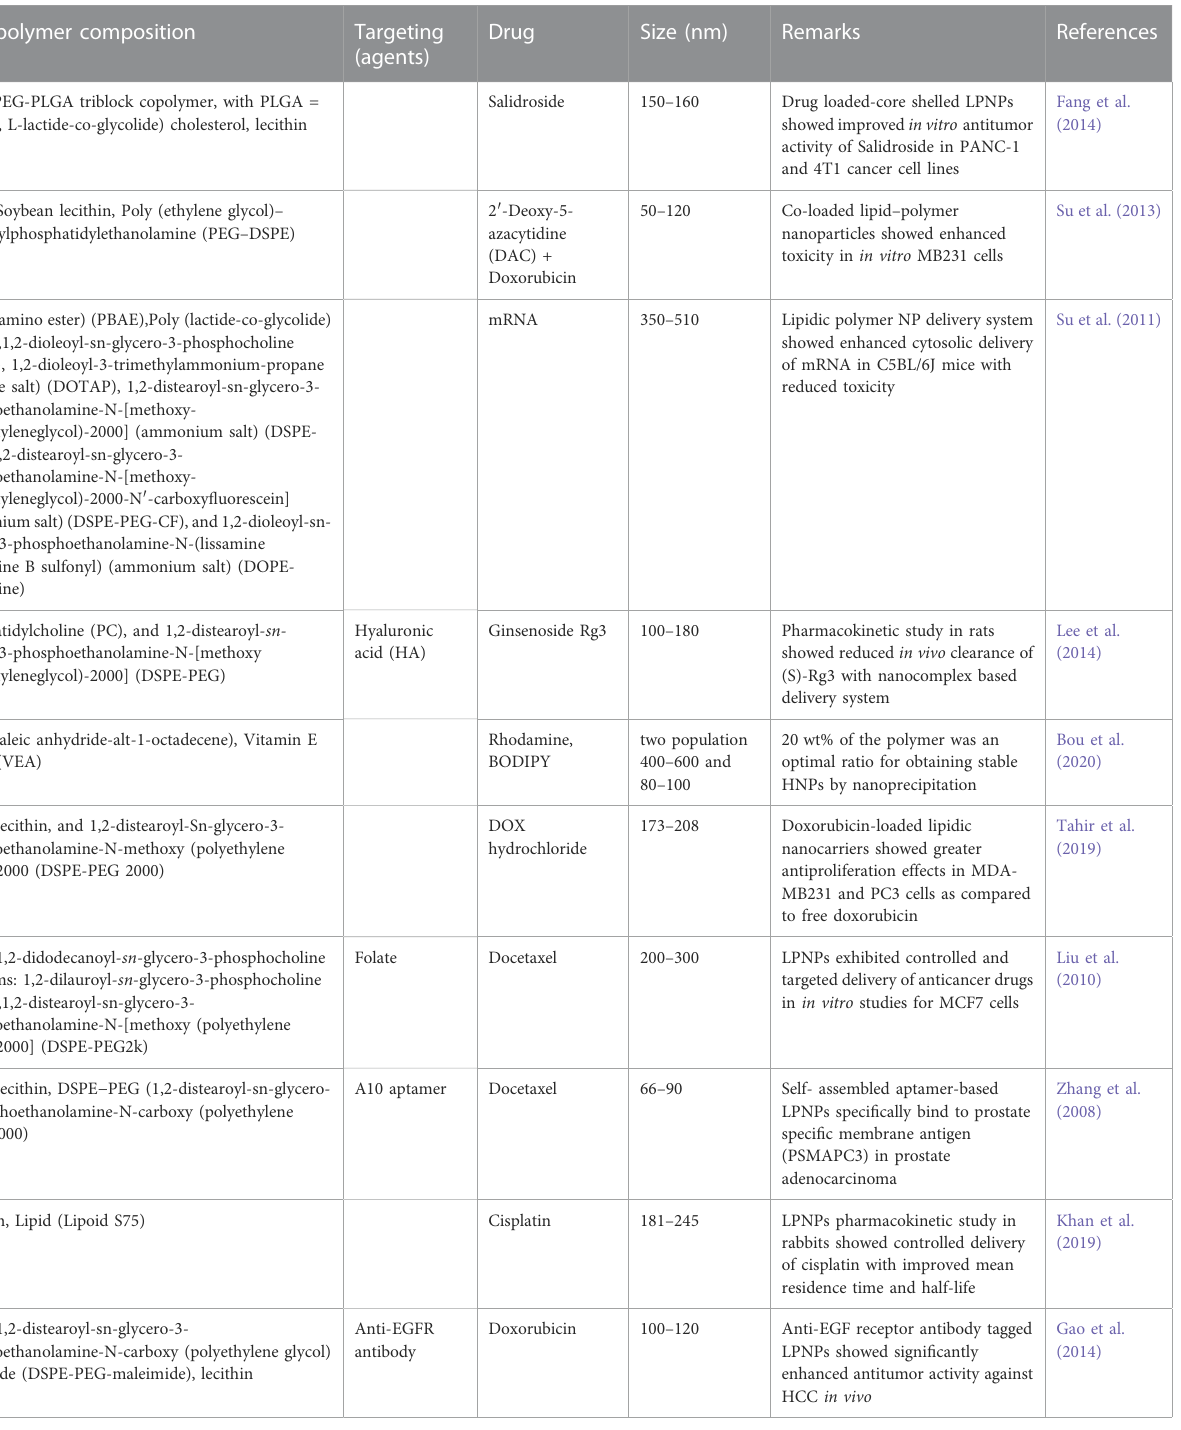
TABLE 3 Examples of lipid polymer nanohybrid formulations. Lipid-polymer